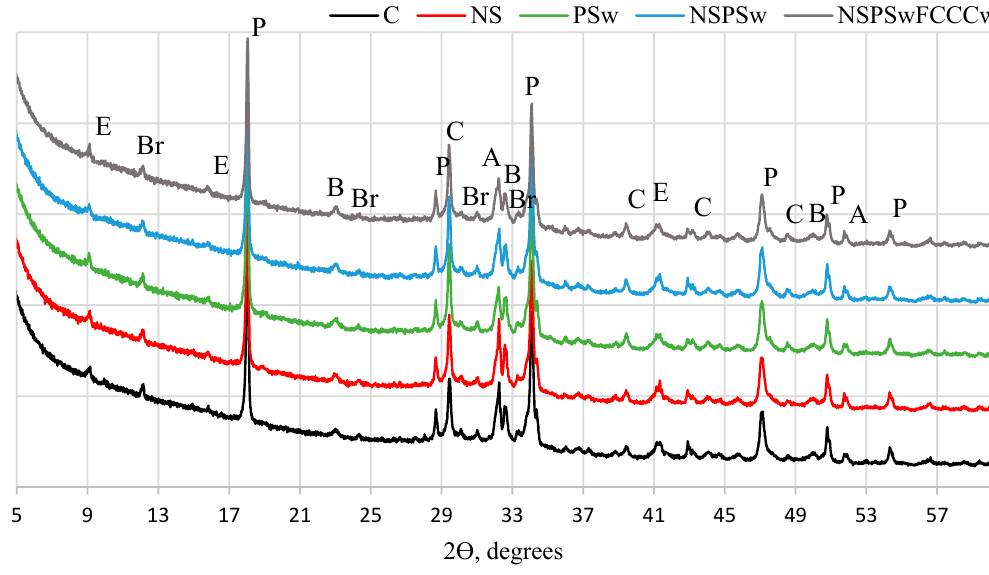
Figure 1. XRD pattern of hardened cement paste at 7 days.